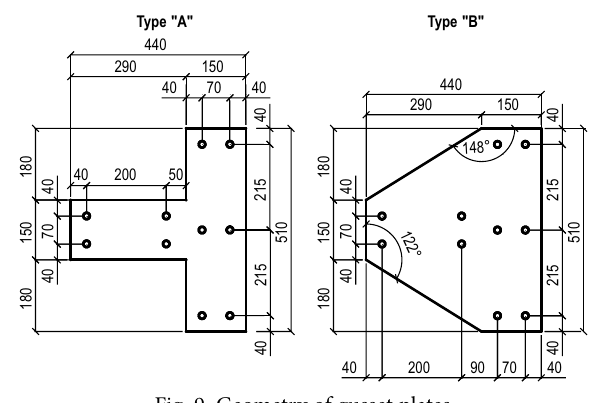
Fig. 8. Numerical simulation models. Bolted connection with gusset plate on the left; without gusset plate on the right (A – load point, B – hinged supports on the top and on the bottom of the columns, C and D – lateral